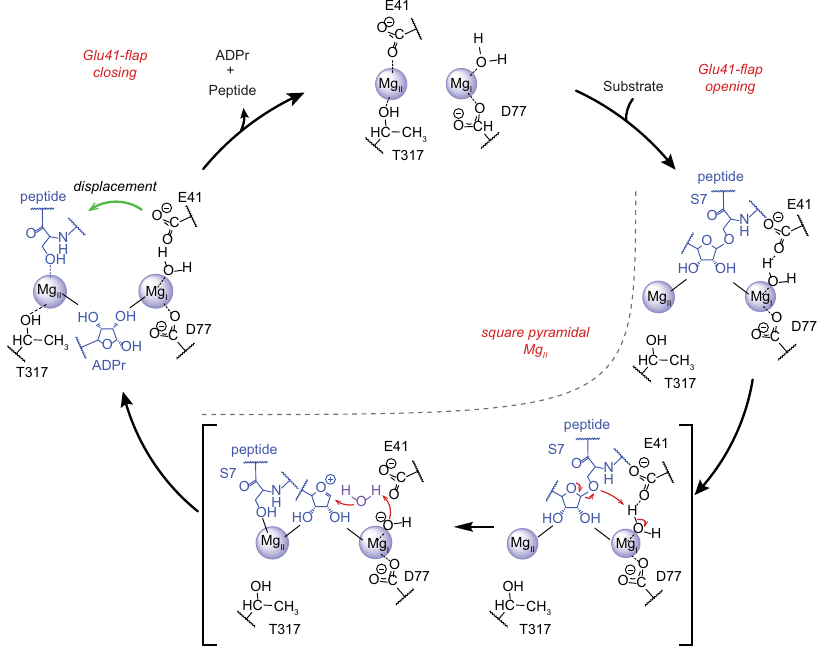
Fig. 8 Proposed reaction mechanism for ARH3. In the resting state, ARH3 adopts a closed conformation, which allows interaction of Glu41 (human) with Mg II . Binding of the ligand occurs preliminary via the ADP-ribose moiety and the ligand needs to displace Glu41 and engage with Mg II to form the pre- catalytic complex. This triggers a conformational change into the open conformation and alters the coordination geometry of Mg II from octahedral to square pyramidal. The displaced Glu41 moves into the second coordination sphere of both magnesium ions and assists in activation of axial water coordinated at Mg I for a nucleophilic attack on 1 ″ C. Cleavage of the glycosidic bond leads to the formation of a oxocarbenium intermediate, which is resolved by a solvent-derived nucleophilic water (purple). Depicted is a step-wise solvent-equilibrated intermediate, but a preassociated/concerted transition state is conceivable. Furthermore, cleavage of the glycosidic bond allows for Mg II to transition back to an octahedral coordination and the de- modi fi ed serine product can be displaced from Mg II by Glu41, which results in closure of the active